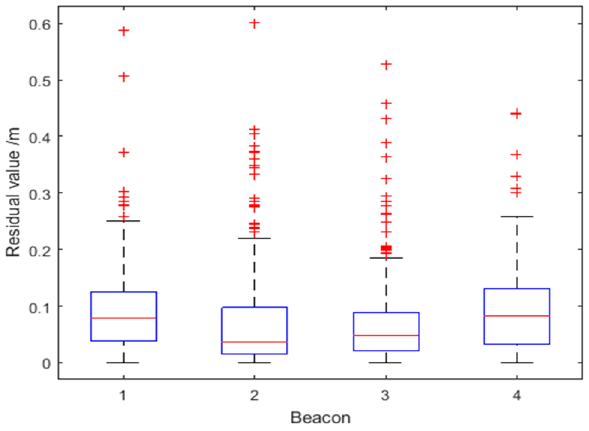
Figure 13. Distributions of residual values for the four Beacons for Route 1.